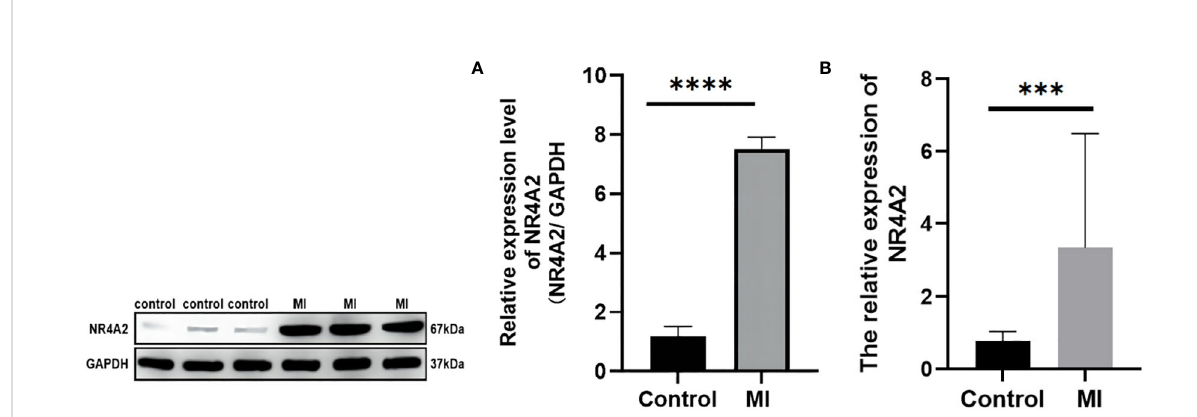
FIGURE 10 qPCR and Western blotting analysis of controls vs. MI rats. (A) Western blot analysis. There were signi fi cant differences in NR4A2 protein levels between controls and MI rats (p< 0.0001). (B) mRNA level of NR4A2 in controls vs. MI (p<0.001). *** indicates P < 0.001, **** indicates P <